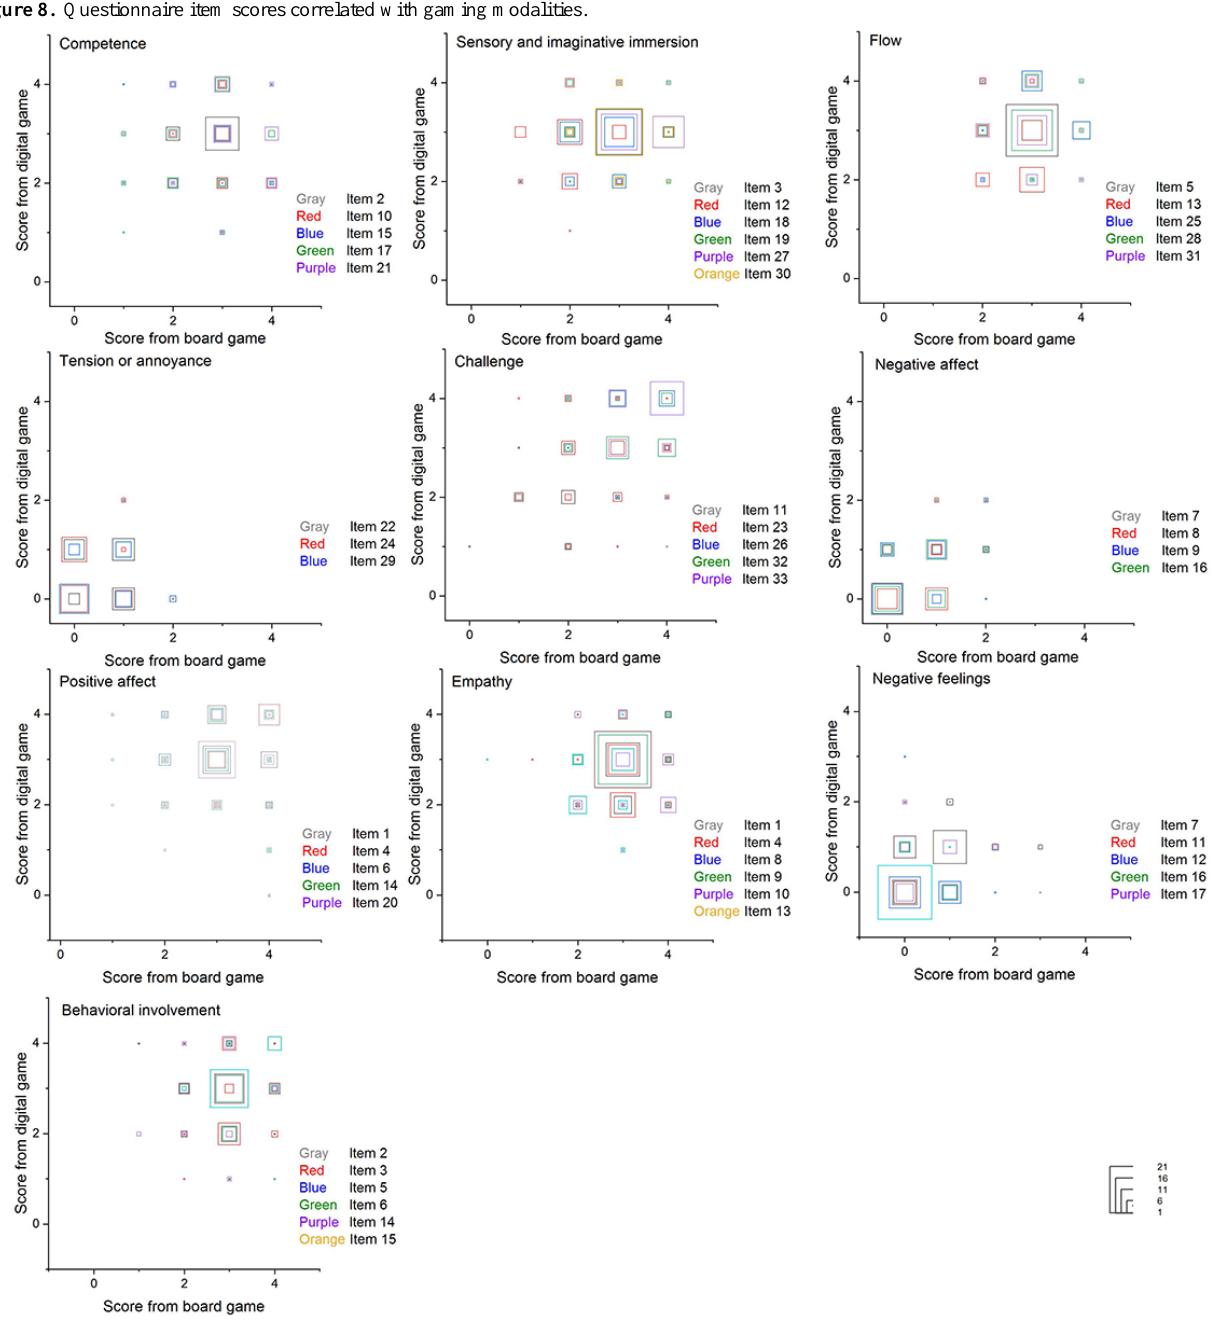
Figure 8. Questionnaire item scores correlated with gaming